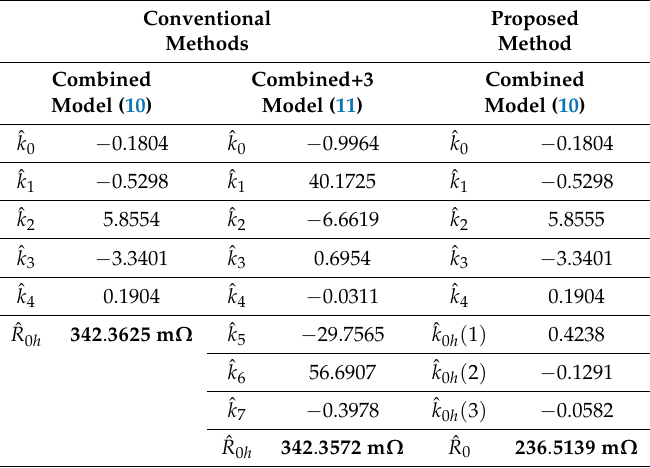
Table 1. Estimated parameters: Samsung-B600BC.